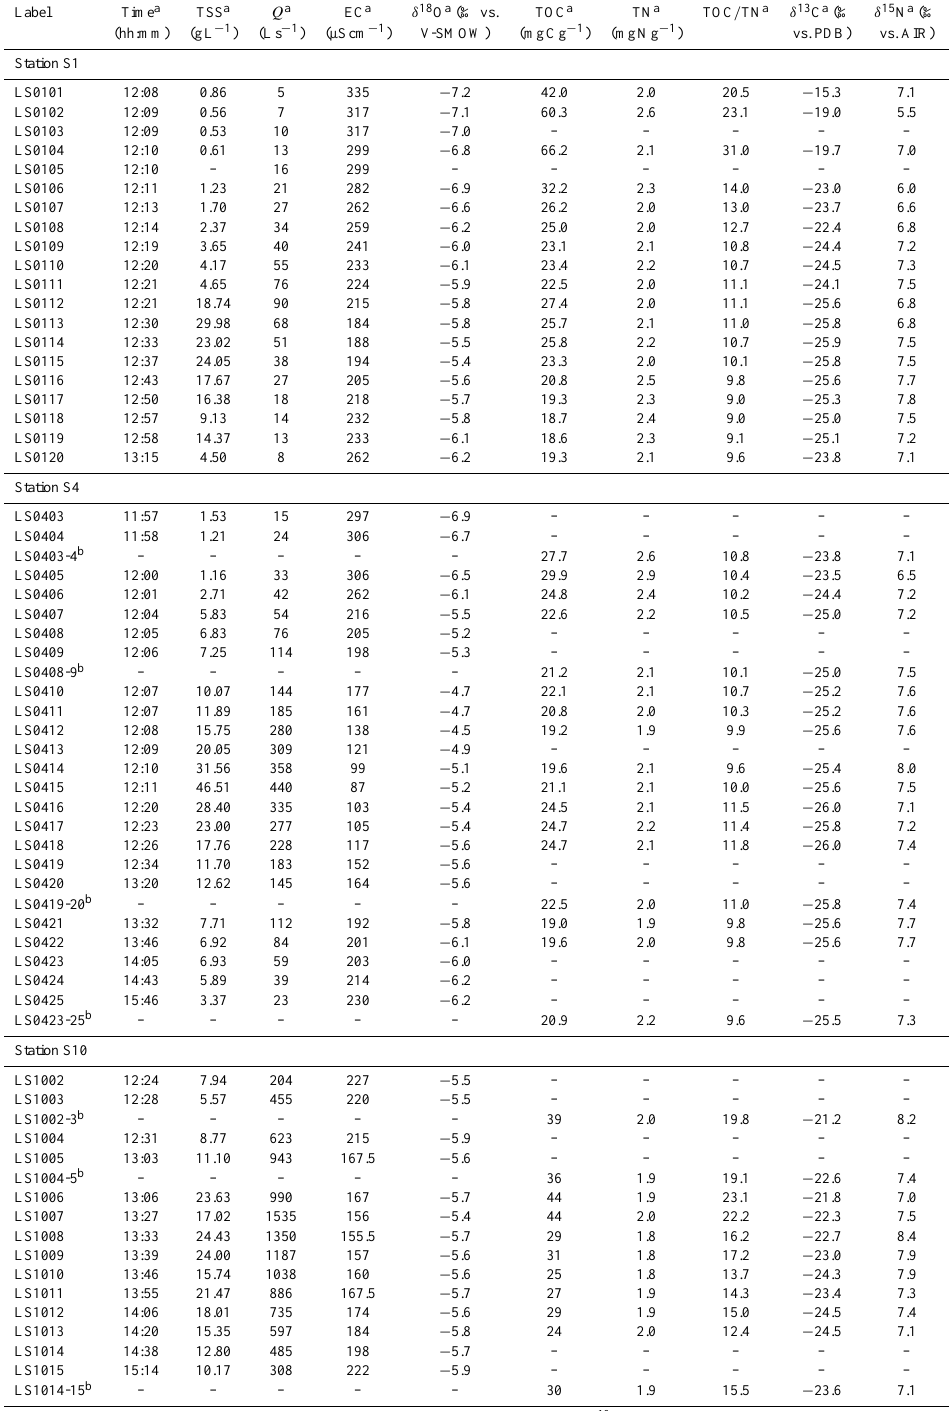
Table A1. Summary of data for stations S1, S4 and S10 during the 23 May 2012 flood.